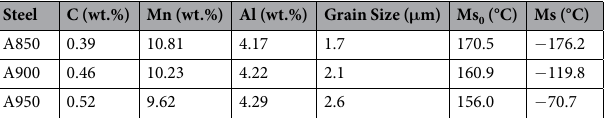
Table 1. C, Mn, and Al contents, grain size, and Ms temperature of austenite in the A850, A900, and A950